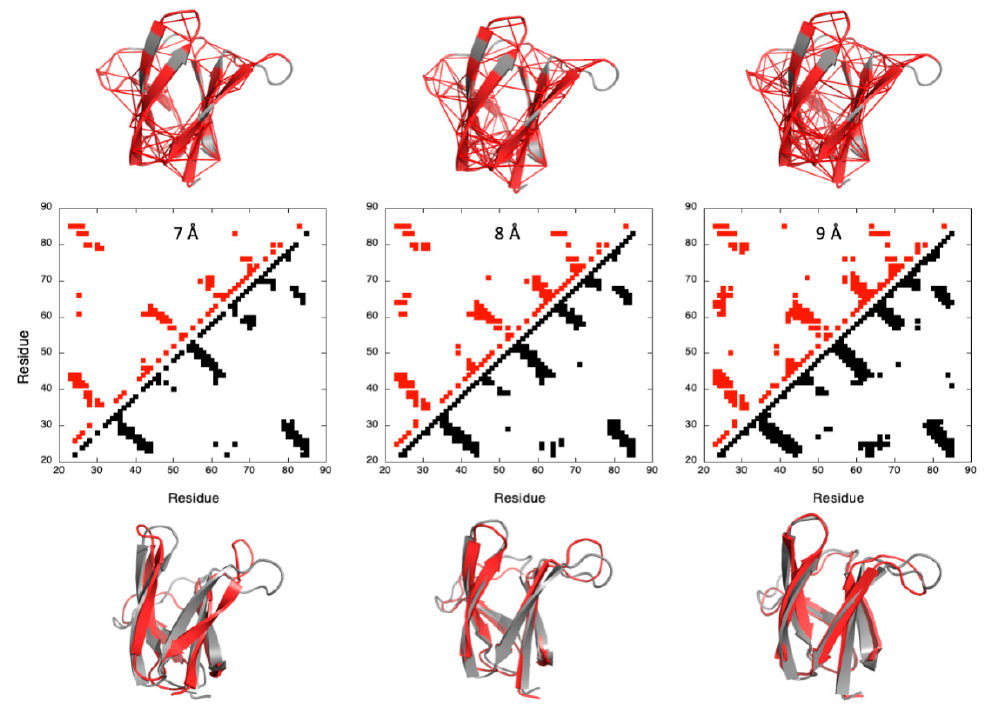
Figure 3. Determining the cut-off threshold for the constraints used for Cyana3 calculation of the structure of AVR-Pia . Central panel: contact maps built from the X-Ray structure of AVR-Pia with cut-off threshold for the C α –C α distances of 7, 8 and 9 Å (from left to right), as indicated. Contacts below the diagonal correspond to residue where the distance to the corresponding C α is lower than the threshold (black filled-squares). Above the diagonal, only the contacts for which fractional probability can be obtained have been reported (red filled-squares). In the upper panel, the corresponding C α –C α distances (110, 155 and 203 distances for cut-off thresholds of 7, 8 and 9 Å, respectively) have been reported on the X-ray structure. Residues involved in these contacts are also colored in red. The lower panel presents the results of the Cyana3 calculations using the corresponding C α –C α distances as upper bound limit restraints. The best models (the closest to the X-ray structure) (red cartoons) are superimposed with the X-ray structure of AVR-Pia (grey cartoons): backbone heavy atoms <r.m.s.d.> of 4.79, 2.77 and 2.85 Å have been measured between the X-ray structures and the models obtained with cut-off threshold of 7, 8 and 9 Å, respectively (from left to right). A similar figure is available for AVR-Pib in the Supplementary Materials (Figure S6).